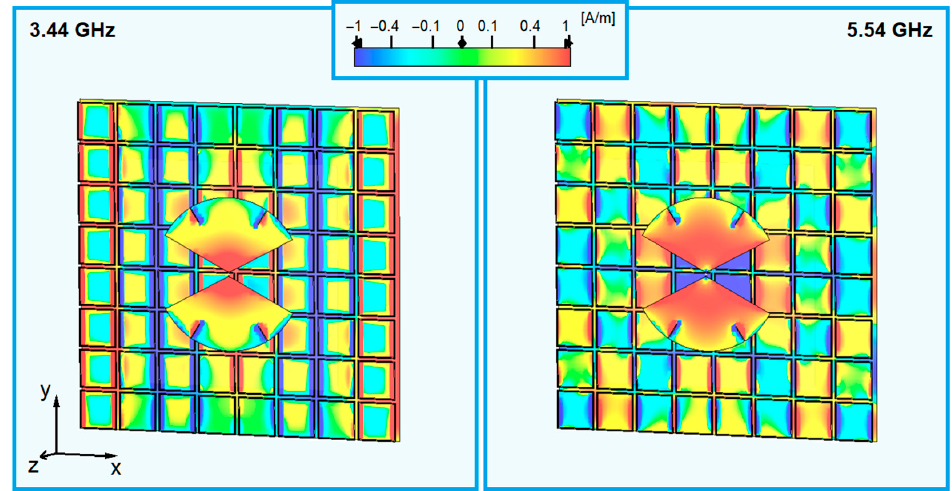
Figure 9. Magnitude of the y -component currents at 3.44 and 5.54 GHz on the 8 × 8-cell AMC.